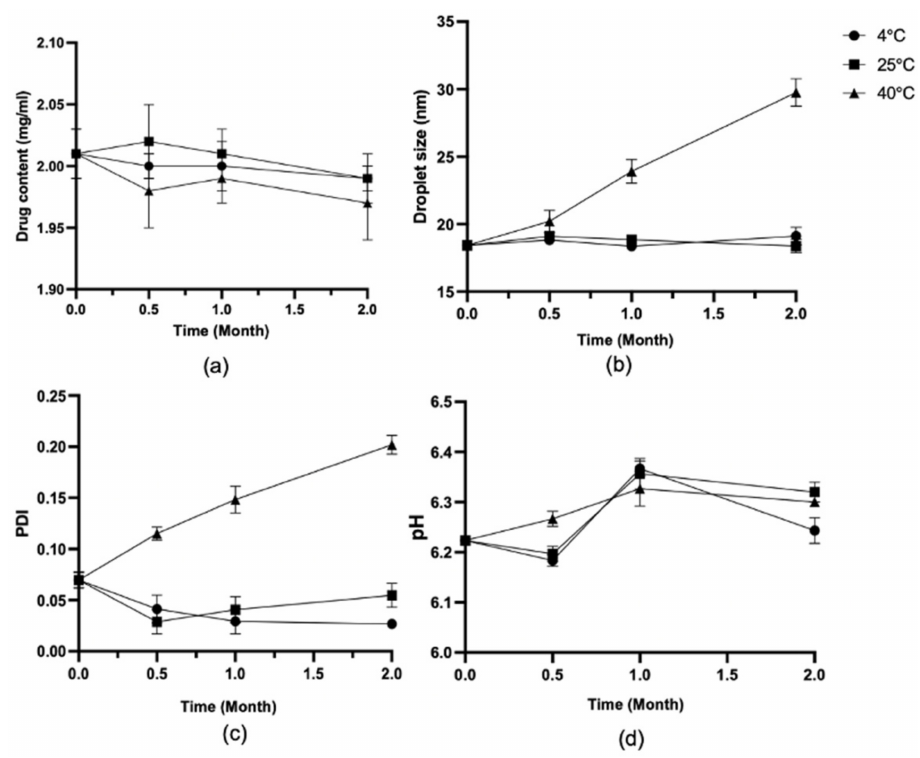
Figure 9. Changes in the LCZ-NE for DC ( a ), DS ( b ), PDI ( c ) and pH ( d ) under different conditions.